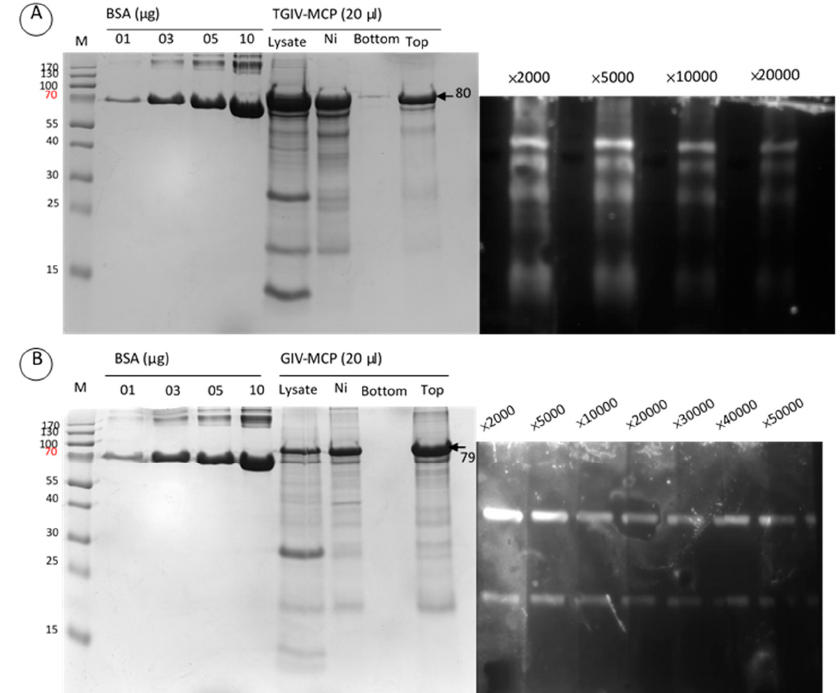
Figure 2. Generation of anti-TGIV–MCP and anti-GIV–MCP polyclonal antibodies. The purification of recombinant MCP proteins and the specificity of the polyclonal antibodies are shown in the left and right panels, respectively. Left panels: Recombinant TGIV–MCP ( A ) and GIV–MCP ( B ) proteins were purified by Ni–NTA column (Ni), followed by centrifugation in centricon filter to displace imidazole in the lysis buffer. The purified recombinant proteins were used to immunize rabbit to generate polyclonal antibodies against TGIV–MCP and GIV–MCP, respectively. Top : the purified recombinant proteins; Bottom : the flow-through waste. Right panels: Western blotting was carried out to verify the specificity of the polyclonal antibodies generated from the recombinant